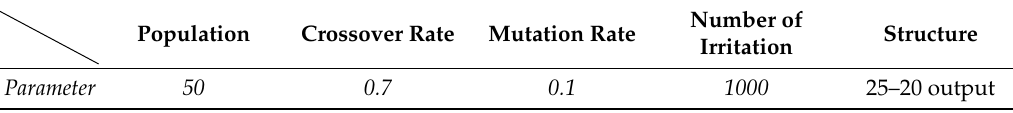
Table 3. Characteristics of the optimized ANN-based genetic algorithm (GA).